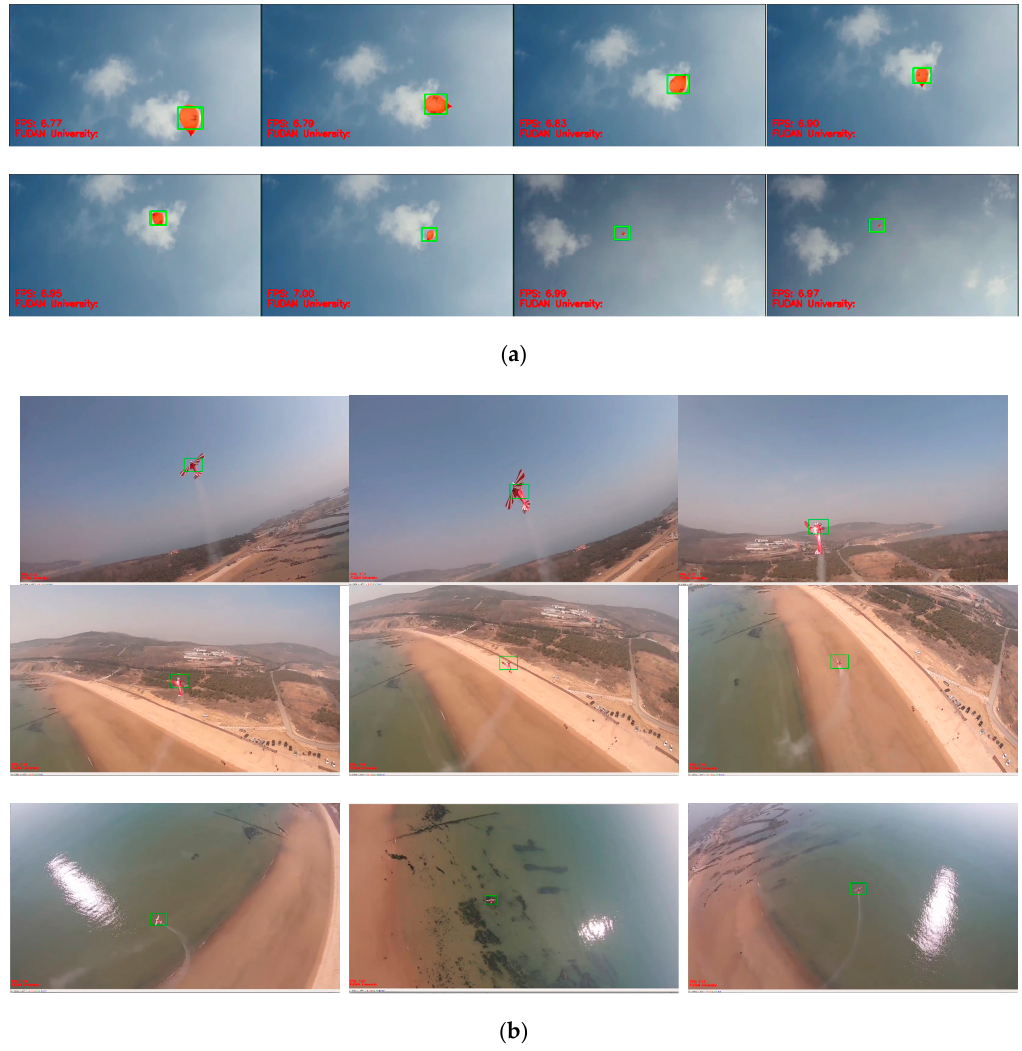
Figure 23. Target tracking test: ( a ) balloon in the air; ( b ) fixed-wing model aircraft in flight. Table 5. Tracking rates of different types of targets.